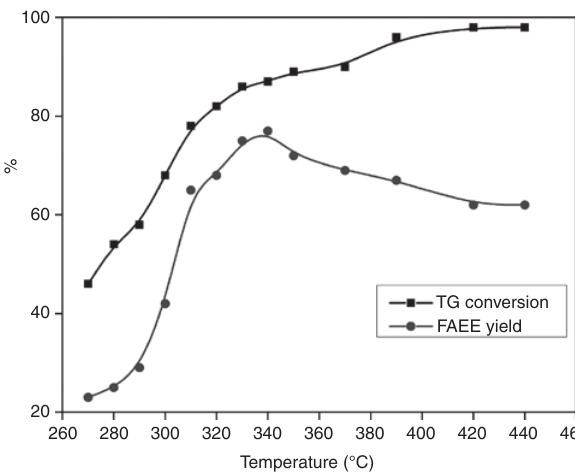
Figure 4: Effect of temperature at reaction conditions: molar ratio 42/1 and 30 min reaction time.